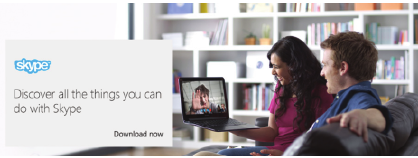
Figure 2: A webpage image containing an appropriate snippet of text (source: